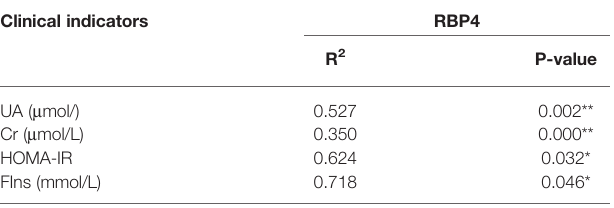
TABLE 3 | Analysis for correlated factors of plasma RBP4. Clinical indicators